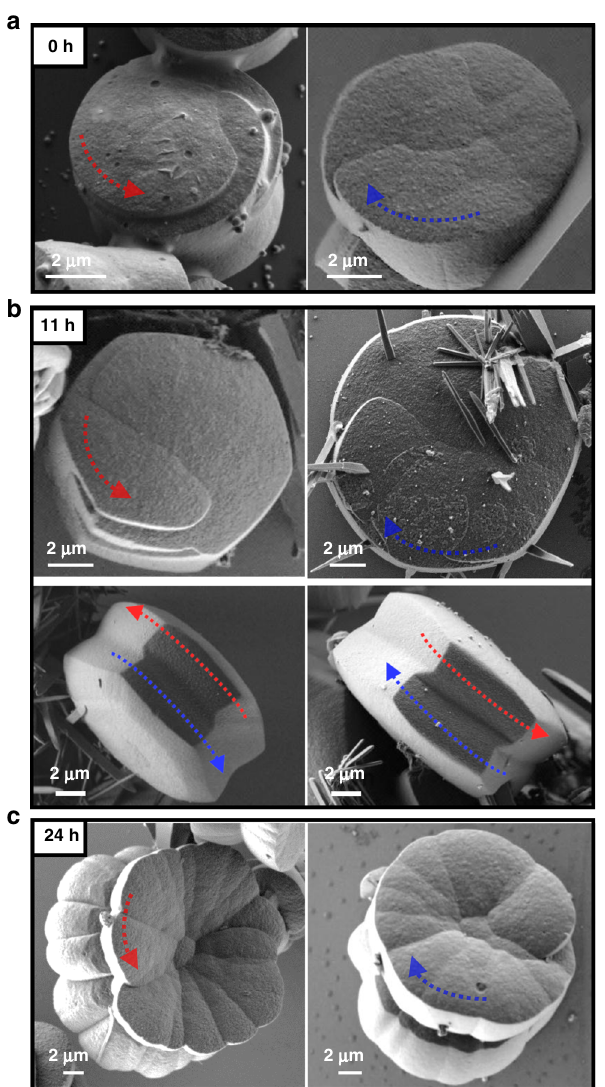
Fig. 7 The emergence of chirality at the morphological level. Scanning electron microscopy (SEM) images of metallo-organic structures recorded a after the solvothermal reaction and after b 11 h, c 1 day of aging. The arrows highlight the